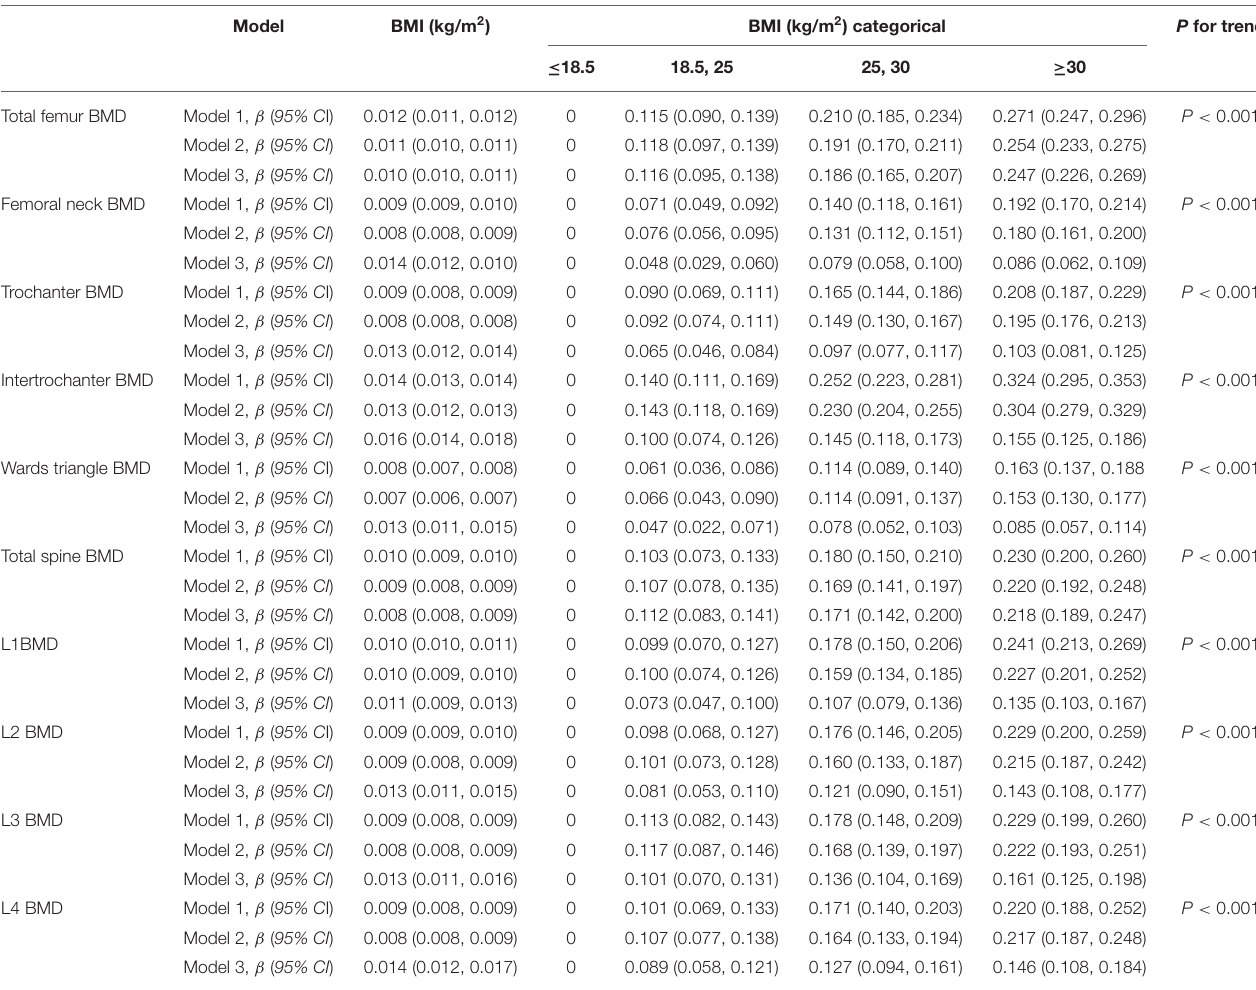
TABLE 2 | Multiple linear regression analysis of the associations between BMI (kg/m 2 ) and BMD (g/cm 2 ) in different